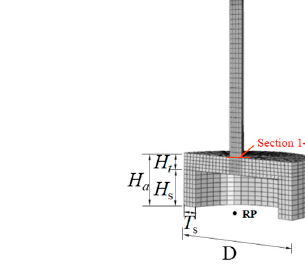
Figure 4. The dimensions of footings: flat base footing, fusiform spudcan footing and skirted footing.